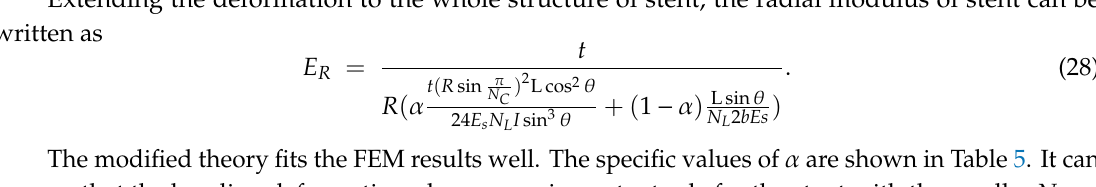
σ , the bending deformation in the x